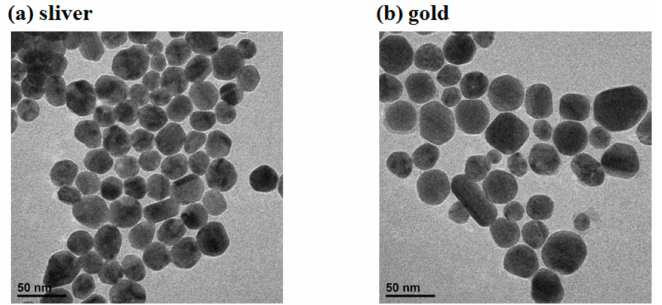
Figure 2. The structure and diameter of silver and gold nanoparticles: ( a ) Silver nanoparticle; ( b ) gold nanoparticle.